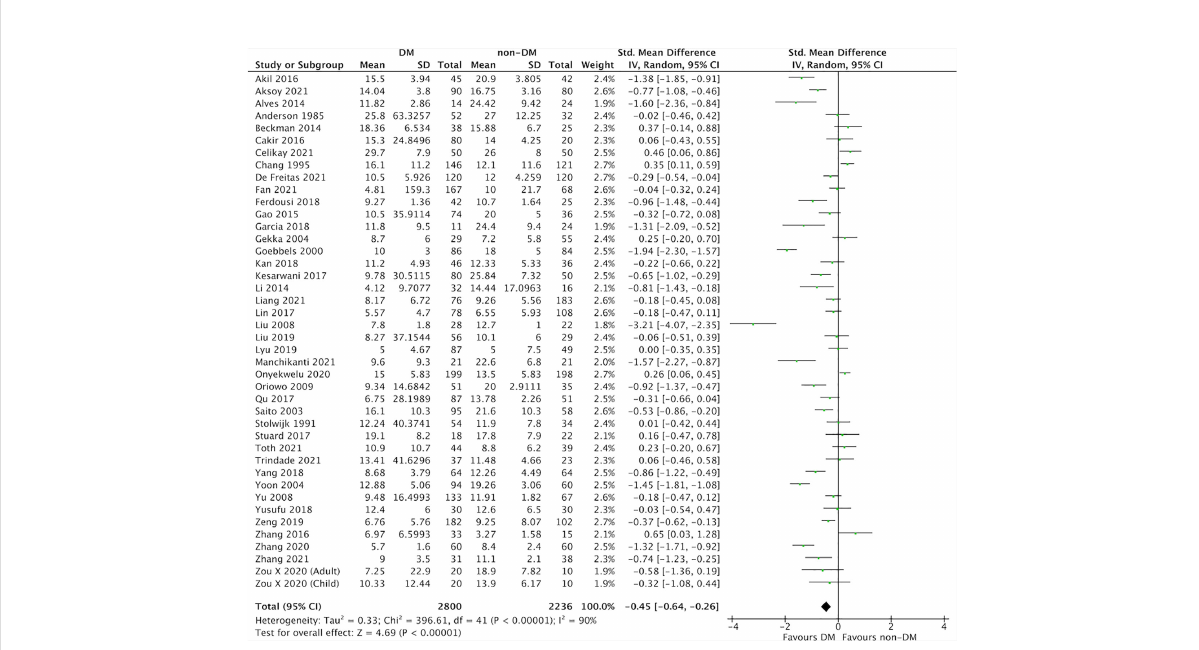
FIGURE 3 Comparison of the severity of dry eye disease (DED) between diabetes mellitus (DM) and non-DM based on Schirmer ’ s 1